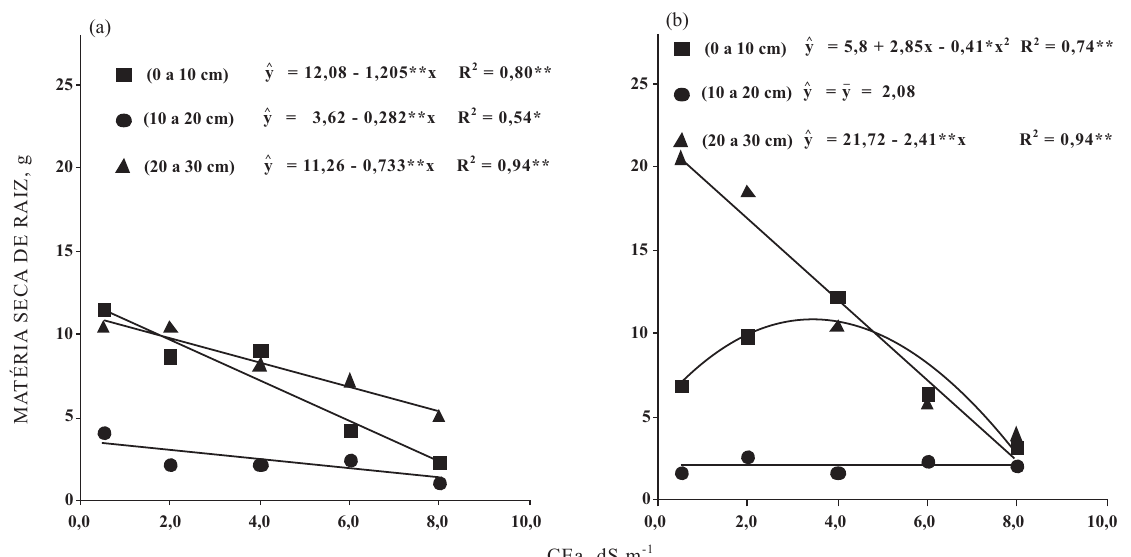
Figura 2. Distribuição das raízes nos vasos cultivados com plantas dos genótipos CSF 18 (a) e CSF 20 (b) de sorgo forrageiro irrigadas com águas salinas com diferentes condutividades elétricas